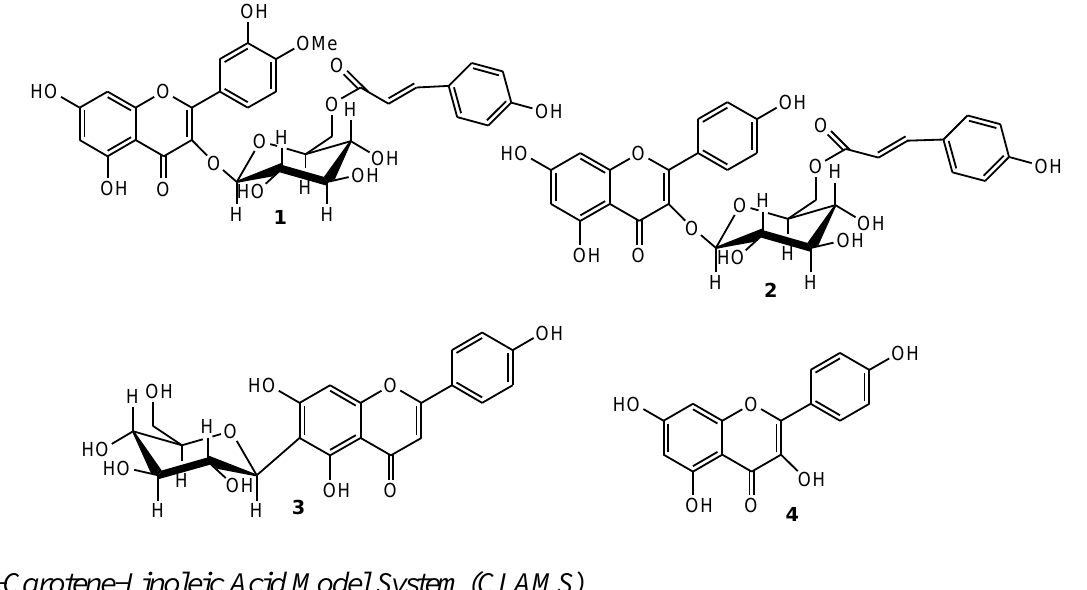
Figure 1. Compounds isolated from Croton gratissimus and Croton zambesicus. Quercetin- 3- O -β-6''(p-coumaroyl) glucopyranoside-3'-methyl ether (helichrysoside-3'-methyl ether, 1 ), kaempferol-3- O -β-6''( p -coumaroyl) glucopyranoside (tiliroside, 2 ), apigenin-6- C -glucoside (isovitexin, 3 ) and kampferol ( 4